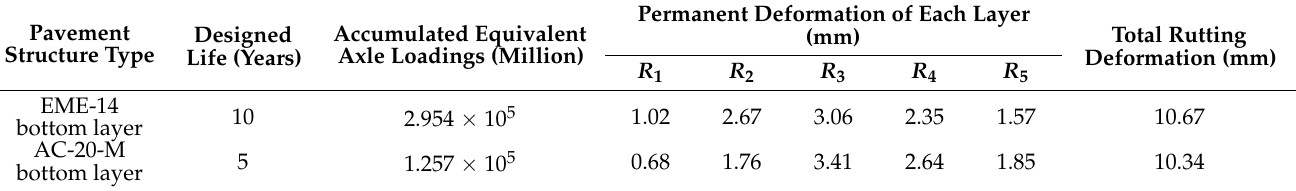
Table 14. Permanent deformation of different pavement structures Pavement Structure